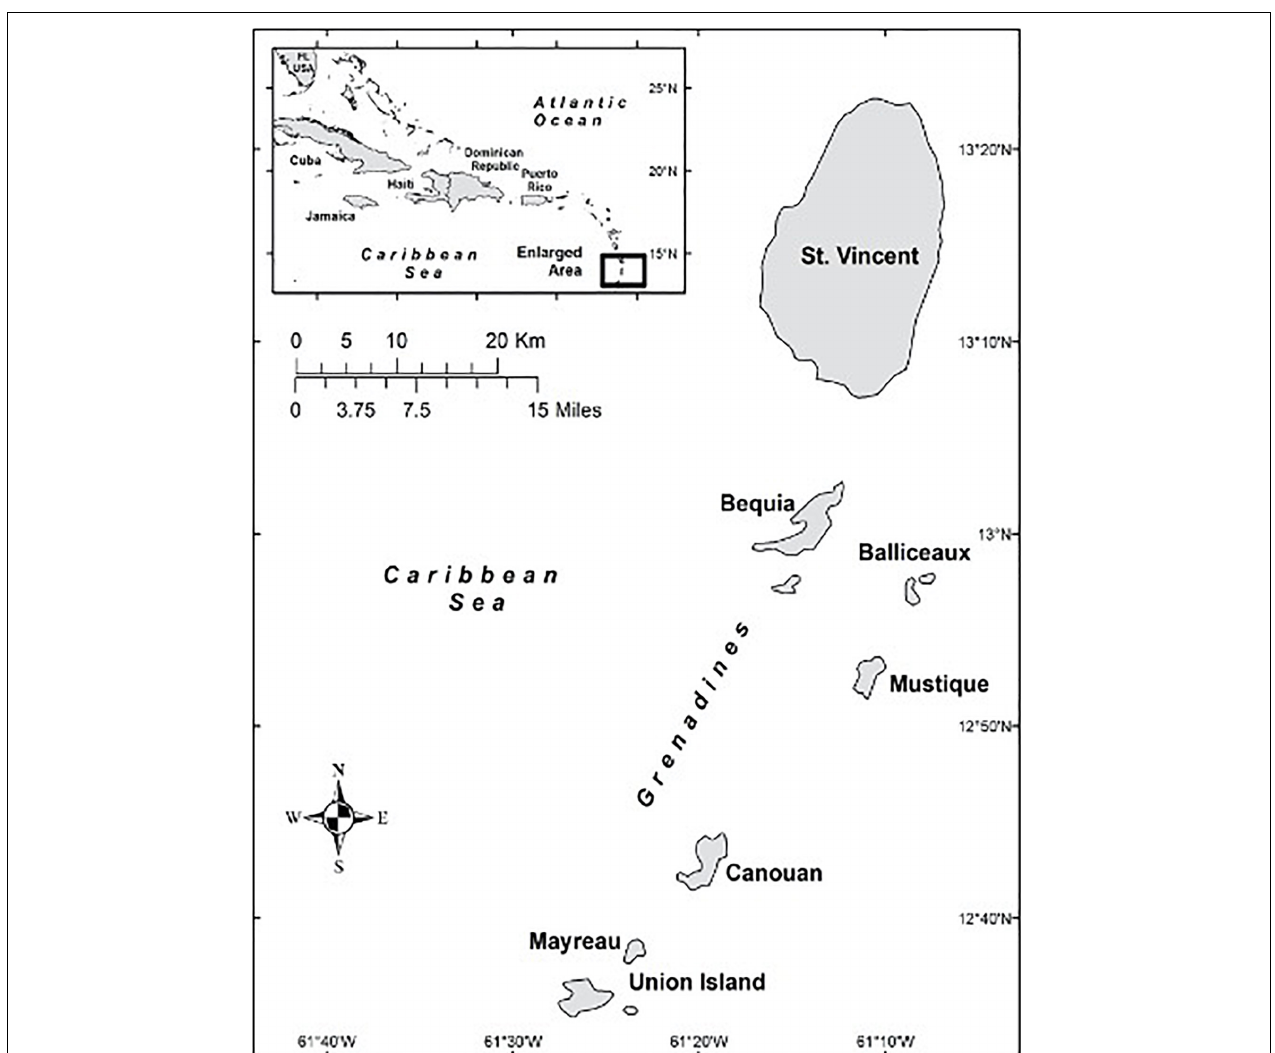
FIGURE 1 | Location of Saint Vincent and the Grenadines, Eastern Caribbean